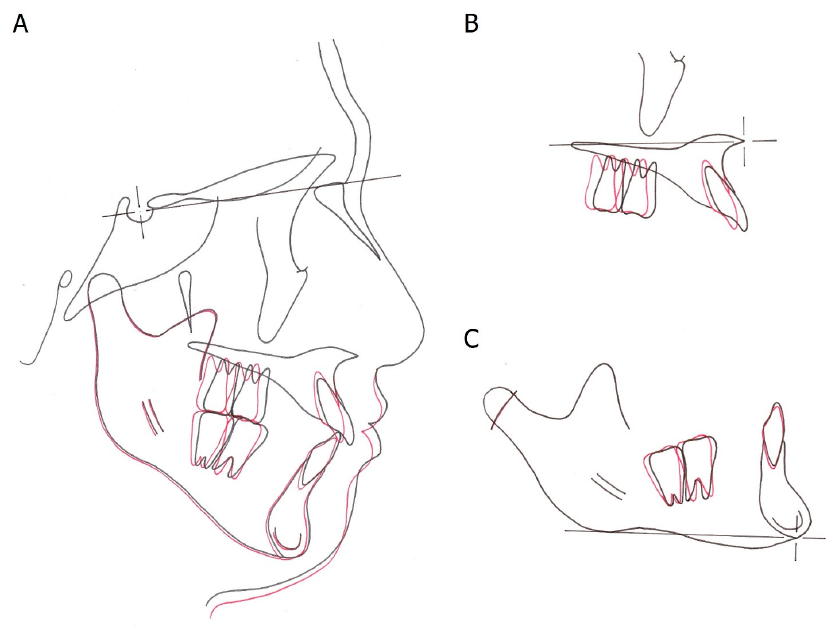
Figure 9. Superimposed tracings of the pre- and post-treatment lateral cephalometric radiographs. ( A ) on the sella-nasion plane at sella; ( B ) on the palatal plane at ANS; ( C ) on the mandibular plane at menton. After two years of retainer use, no significant relapse and change was observed (Fig- ures 10–12). The occlusion was stable, and appropriate guidance of lateral movement and grinding was confirmed.